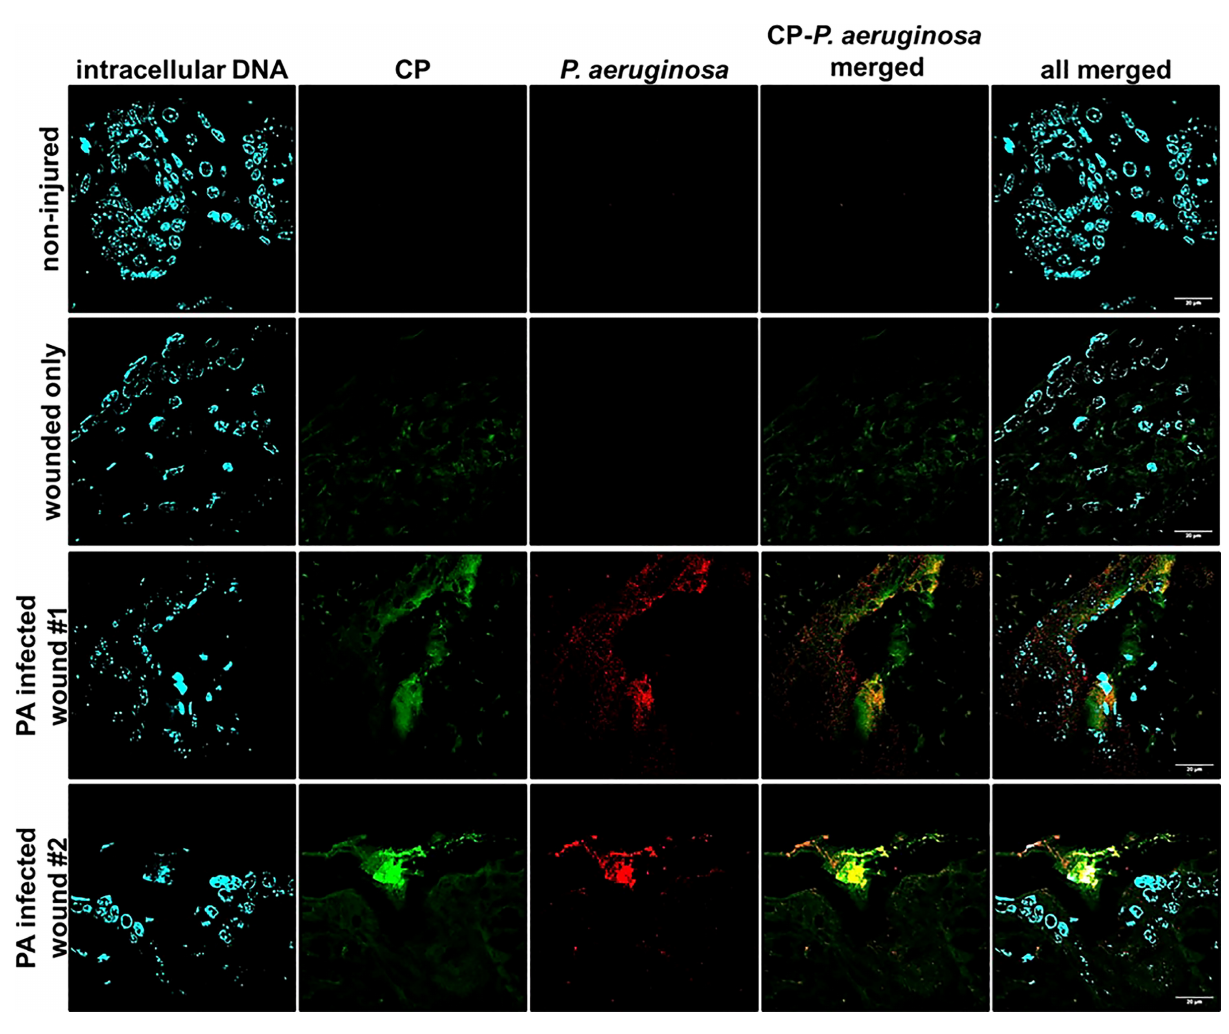
FIGURE 3 | Mouse CP signals overlap with bacterial signals in paraf fi n-embedded dorsal tissue sections. Non-injured skin control collected 12 days post-depilation display no background CP or bacterial signal, 12-day uninfected wound only data reveals minimal CP signal and no background bacterial signal. Duplicate samples of 12-day PAO1-infected wounds reveal both CP and bacterial signals. CP was detected by staining with Alexa fl uor 488-tagged Goat anti-Rabbit antibody, PAO1 was detected by staining with Alexa fl uor 594-tagged Goat Anti- Chicken antibody and nuclei were detected by staining with the cell-permeant dye, Hoechst 33342. Images are shown at 100X magni fi cation and processed using